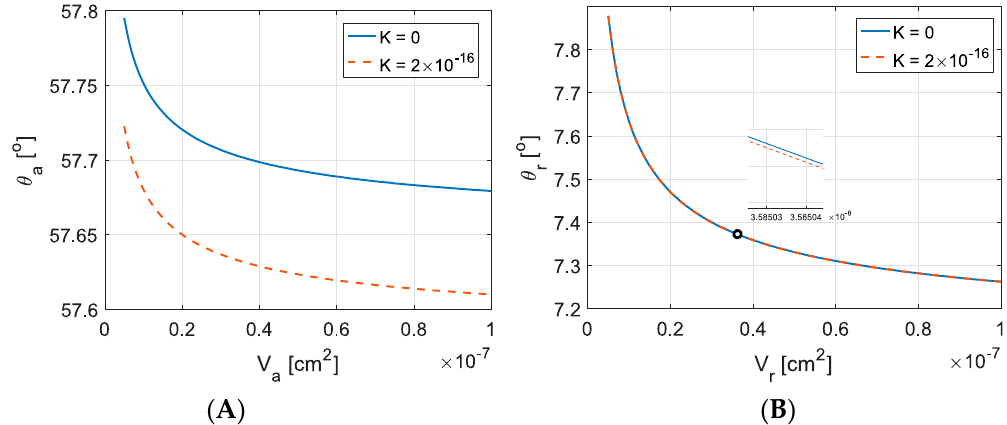
Figure 11. Effect of variation of volume of the droplet on: ( A ) advancing; and ( B ) receding contact angles. Reproduced with permission from [20]. Copyright © 2018 Elsevier B.V.